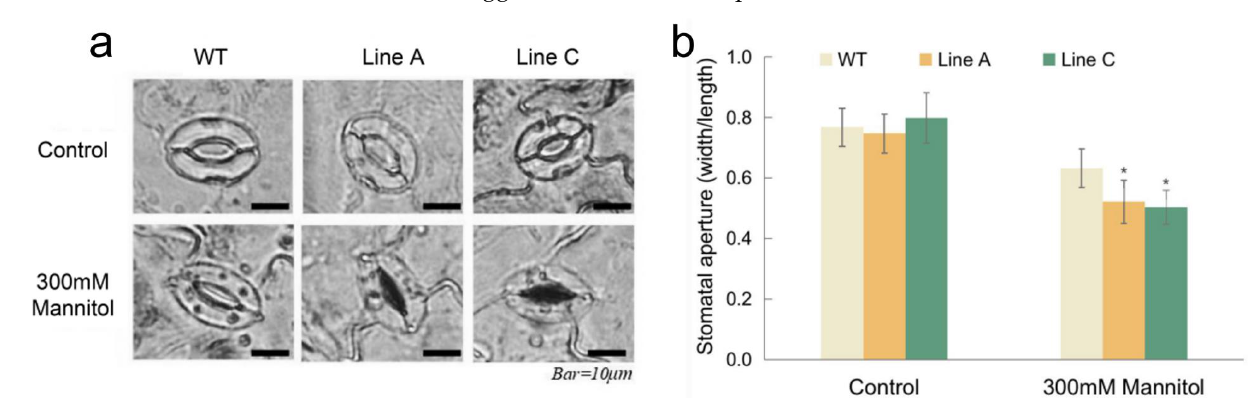
Figure 6. Measurements of stomatal aperture. ( a ) Microscopy observation of the stomatal aperture of OE and WT plants treated by 300 mM mannitol. ( b ) Measurement of the stomatal aperture with or without mannitol treatment. Data are presented as mean and SD values of three independent experiments. Asterisks indicated significant difference (* p < 0.05, by independent sample t -test) comparing to